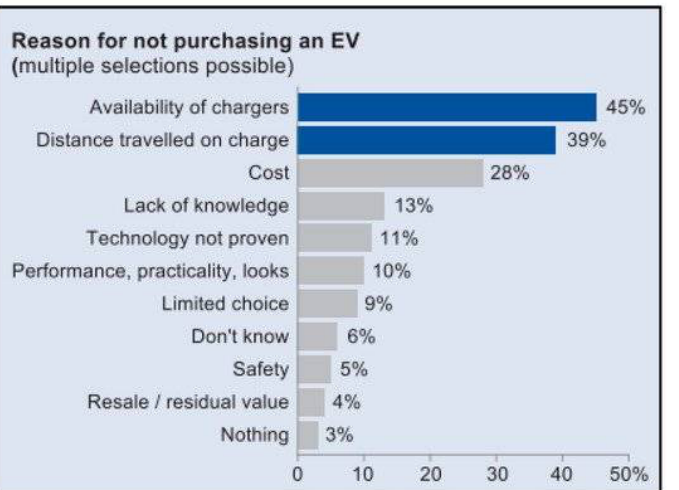
Figure 16. Schematic of a battery electric vehicle [78].